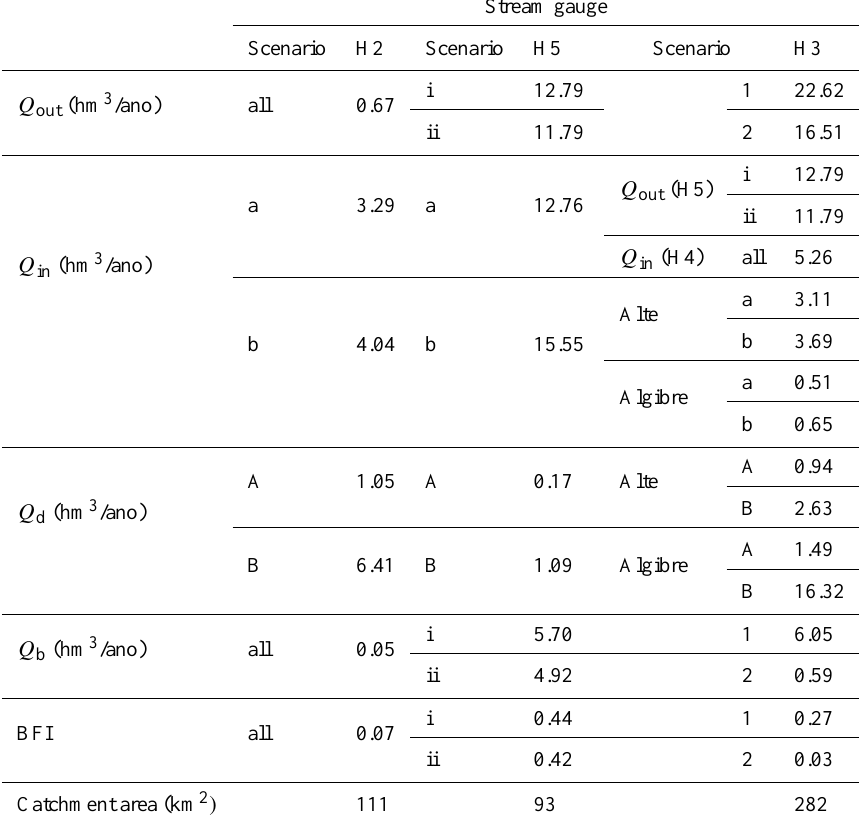
Table 3. Results of Eq. (1) and Eq. (2) variables – surface water outflow ( Q out ) and inflow ( Q in ) to aquifer, surface runoff generated within the aquifer area ( Q d ) , base flow contributions ( Q b ), base flow index (BFI) for different tested scenarios and stream gauge catchment areas (for scenarios detailed description see Table